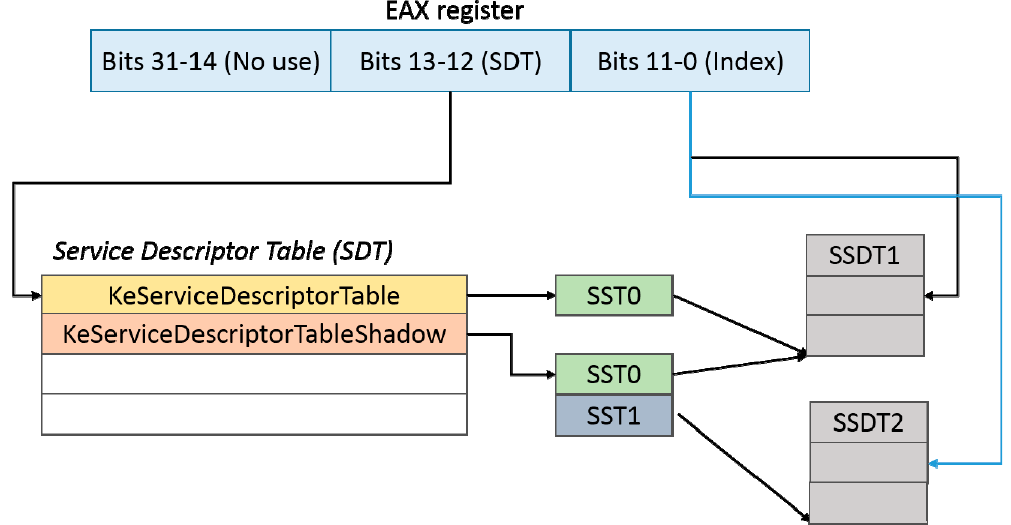
Figure 2. Relationships among EAX register (a 32-bit processor register of x86 CPUs), service descriptor table (SDT), and system service dispatch table (SSDT)1.